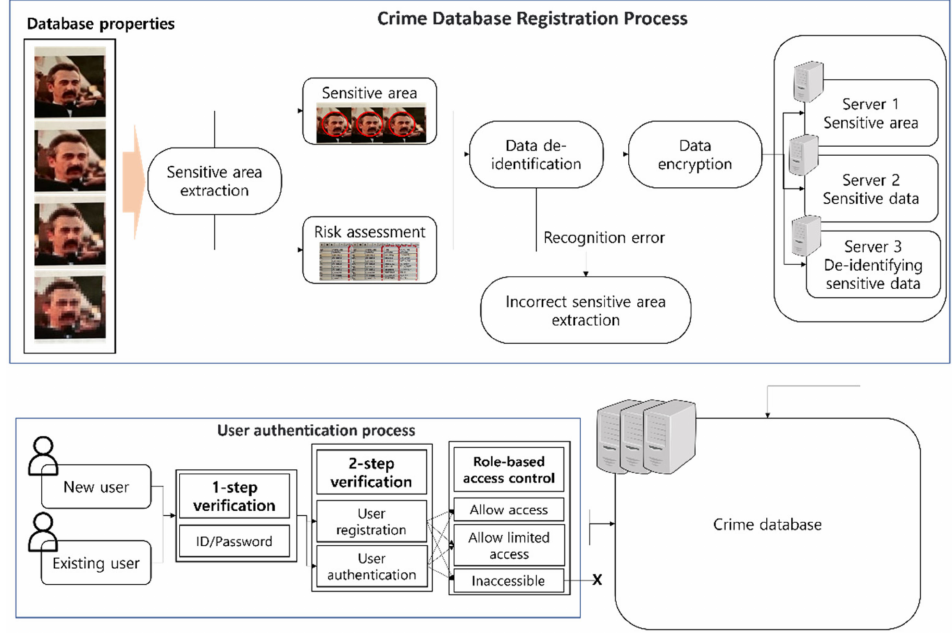
Figure 2. A diagram of the de-identification mechanism of user data in the imaging